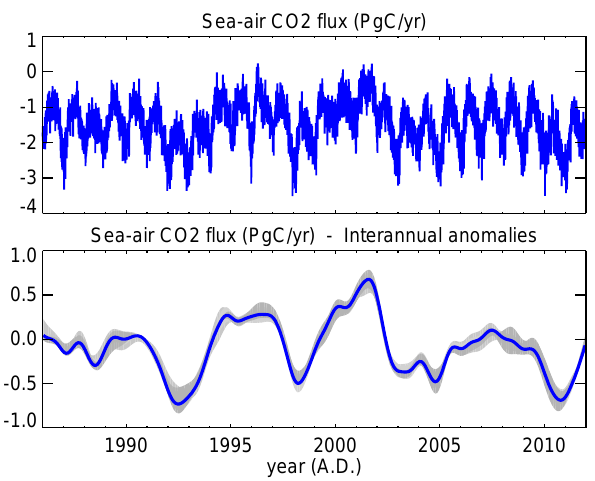
Fig. 3. Top: Globally integrated sea–air CO 2 exchange estimated Figure 3. Top: globally integrated sea–air CO 2 exchange estimated from SOCAT data (run SFC , blue). Negative values indicate an from SOCAT data (run SFC , blue). Negative values indicate an ocean CO 2 sink. Bottom: interannual anomalies of the globally in- ocean CO 2 sink. Bottom: Interannual anomalies of the globally tegrated sea–air CO 2 exchange. The time series have been desea- integrated sea–air CO 2 exchange. The time series have been desea- sonalized and filtered for interannual variations, and the 1993–2008 sonalized and filtered for interannual variations, and the 1993–2008 mean flux has been subtracted (positive values indicate an increased mean flux has been subtracted (positive values indicate an increased ocean CO 2 source or a decreased sink). The light grey band around ocean CO 2 source or a decreased sink). The light-grey band around the standard case comprises a set of sensitivity cases (Sect. 2.3.4). the standard case comprises a set of sensitivity cases (Sect. 2.3.4). The time period shown excludes the first year for spin-up and the years after the end of SOCAT v2 (end of